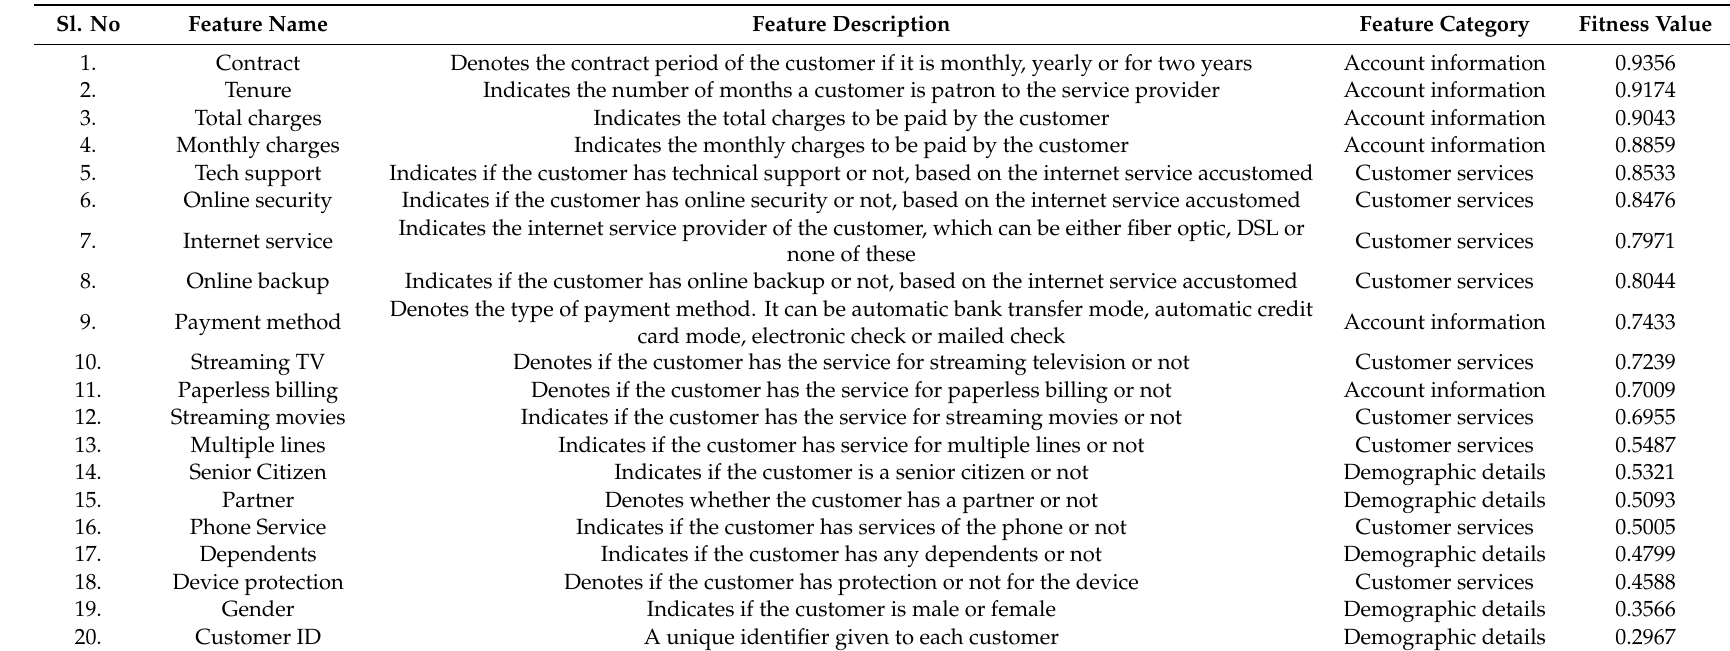
Table 4. Churn features arranged as per their relevance via fitness